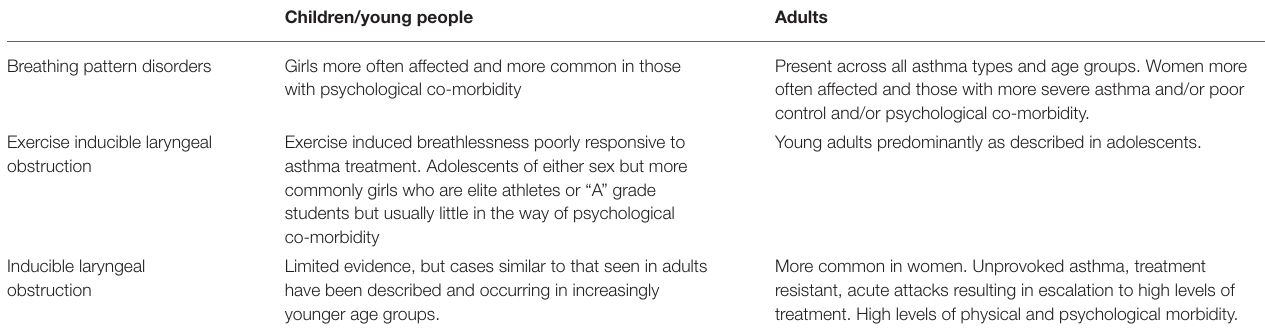
TABLE 3 | Dysfunctional breathing in asthma: adults vs.